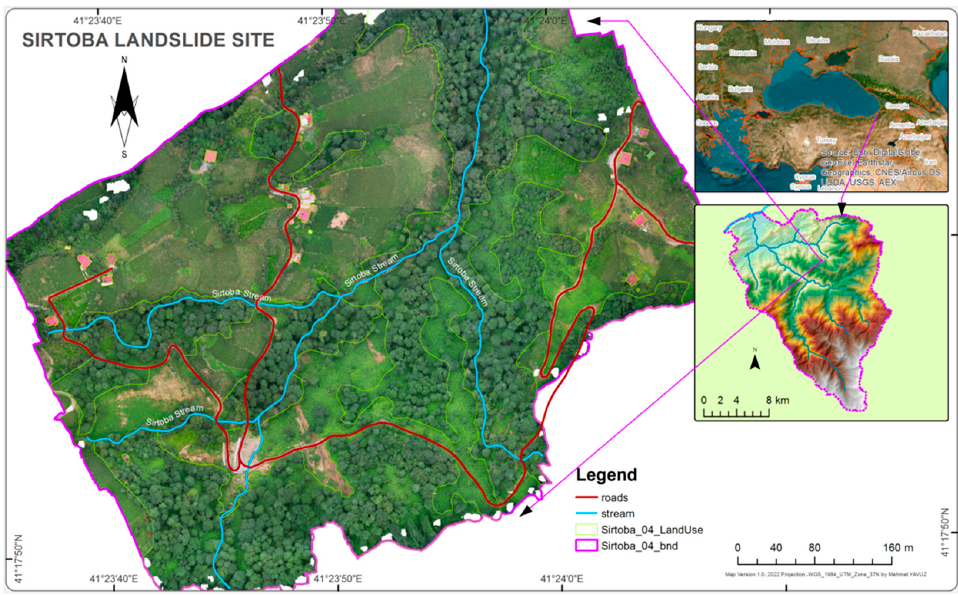
Figure 4. The location of the Sirtoba landslide site within the Arhavi River Watershed (TURKEY).